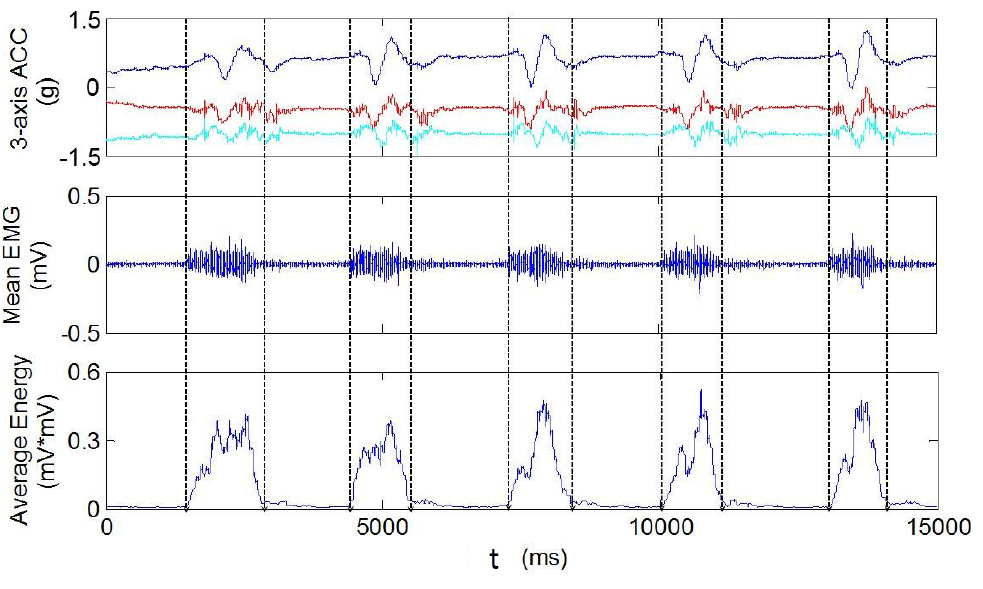
Figure 9. An example of the segmentation results of sequential right-handed